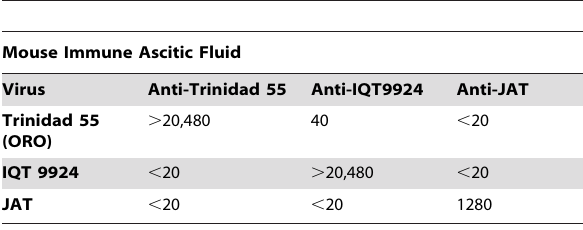
Table 3. Neutralization of ORO, IQT9924 and JAT virus by mouse